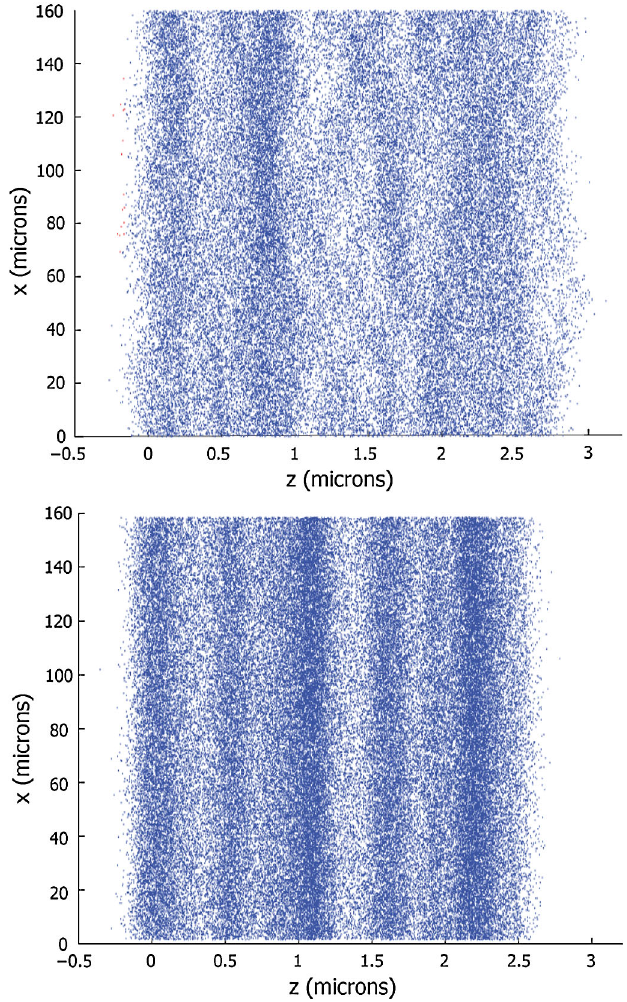
FIG. 4. Longitudinal Fourier transform of the electric field (in arbitrary units) generated by an uncorrelated electron distribu- tion for (cid:2) ¼ 270 and (cid:3) ¼ 0 : 5 (cid:11) m , illustrating the features of the three-dimensional limit of space-charge fields.